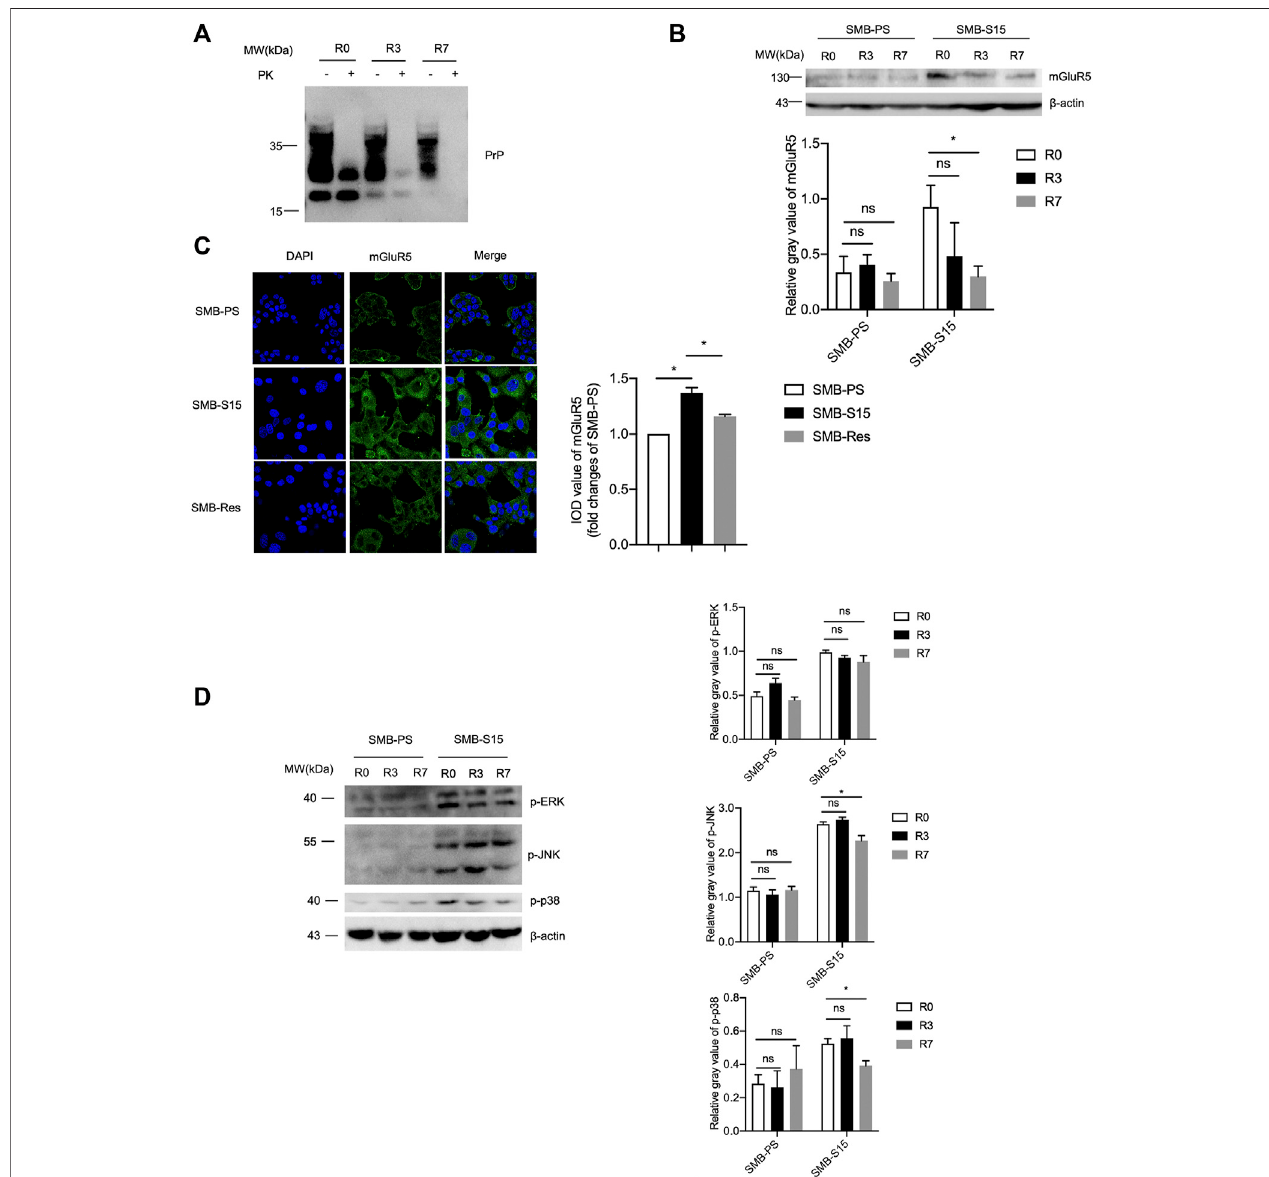
FIGURE 6 | The levels of mGluR5 and its downstream elements after removal of prion replication in SMB-S15 cells. (A) PrP-speci fi c Western blots of resveratrol- treated SMB-S15 cells. R0: The lysates of SMB-S15 cells without treatment of resveratrol. R3: The lysates of SMB-S15 cells receiving 10 µM resveratrol for 3 days. R7: The lysates of SMB-S15 cells receiving 10 µM resveratrol for 7 days. PK proteinase K. (B) Top: Western blots for the levels of mGluR5 in two SMB cell lines before and after removal of PrP Sc . Bottom: Densitometric analyses of the average gray values of the signals of mGluR5 after being equilibrated with that of β -actin. (C) Left: Immunocytochemical assaysof thedistributionsof mGluR5 invariousSMB cell lines.The images of DAPI(blue), mGluR5 (green), and merge areindicatedabove. Right: The IOD analysis for the signals of mGluR5 in the images of various SMB cell lines. The IOD value of mGluR5 in SMB-PS cells is set to 1 and Y -axis represents the fold changes in SMB-S15 versus SMB-PS. (D) Left: Western blots for the levels of p-ERK/p-JNK/p-p38 in two SMB cell lines before and after removal of PrP Sc . Right: Densitometric analyses of the average gray values of the signals of p-ERK/p-JNK/p-p38 after being equilibrated with that of β -actin.